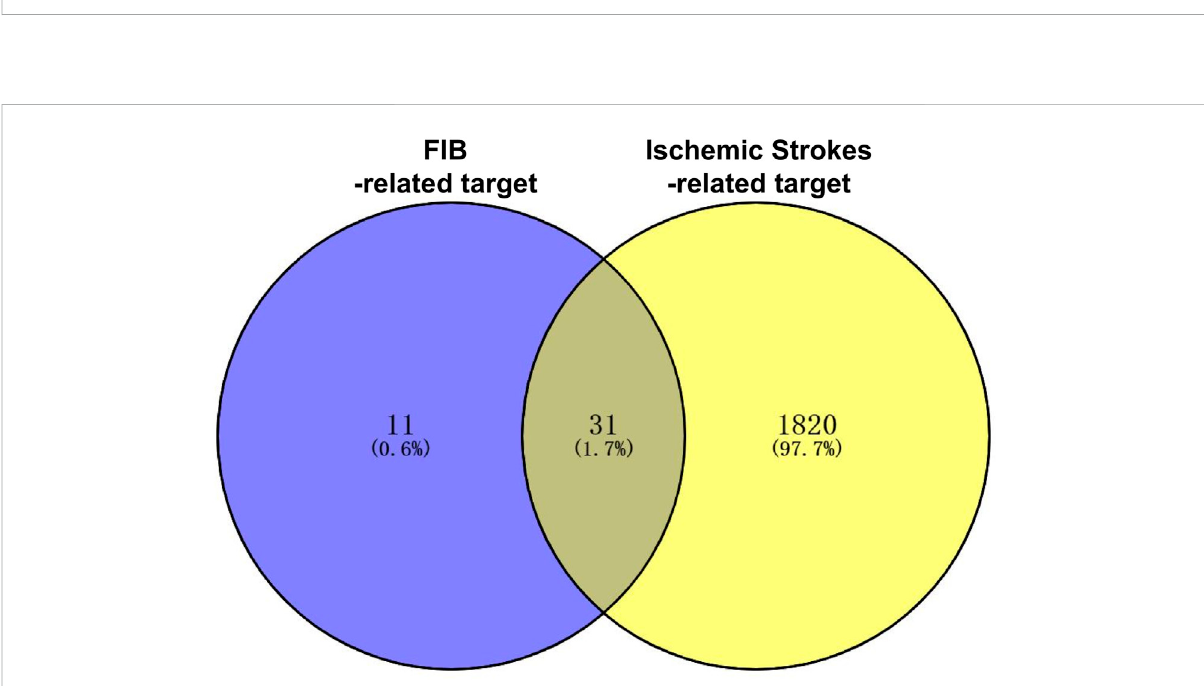
FIGURE 2 The 31 overlapping targets of FIB and Ischemic Strokes were identi fi ed by a Venn diagram.